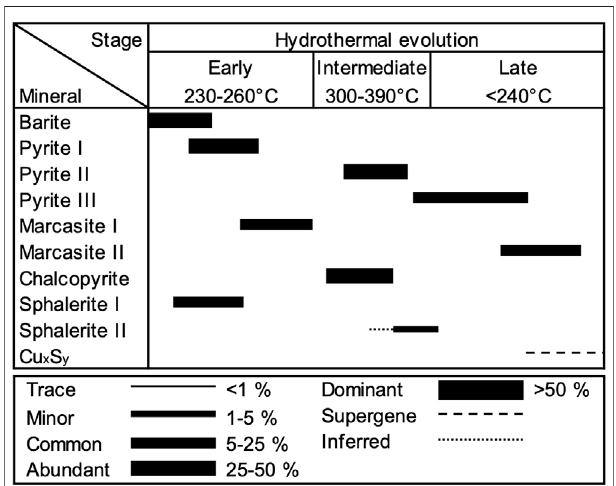
FIGURE 9 | Paragenetic sequence of chimney evolution at Maka. Abundances estimated by optical and electron microscopy, as outlined in Table 3 . The temperatures combine the in-situ measurements at the active chimneys by temperature probe (intermediate stage) and the estimated precipitation temperatures based on Fe/Zn in sphalerite I (early stage) and II (late stage, cf. Section 5.1 ).